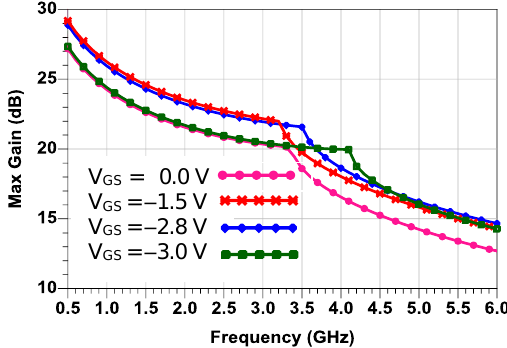
Figure 2. Simulated maximum available gain of the CGH40010F device for different biasing